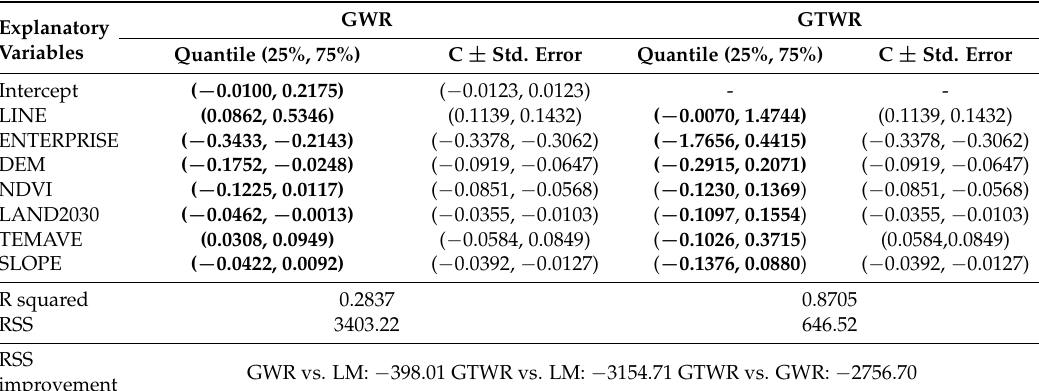
Table 5. Statistical summary of the GWR and GTWR